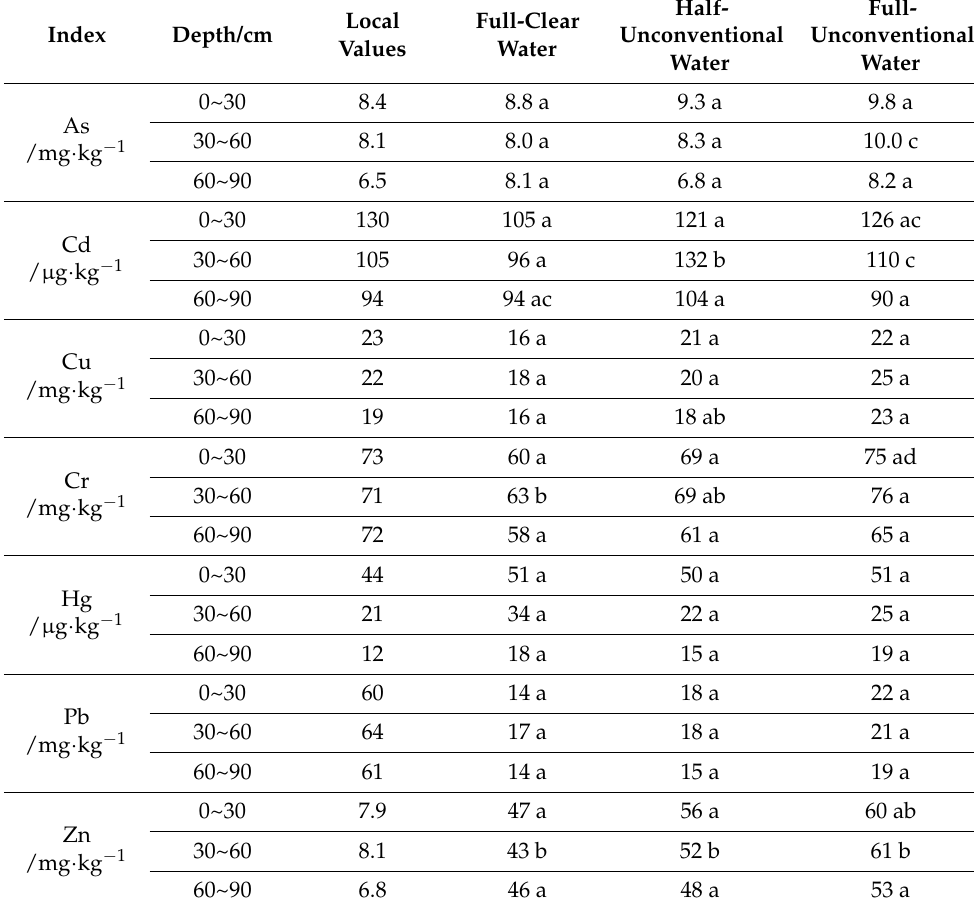
Table 3. Soil heavy metals contents with different volumes of unconventional water agricultural utilization.